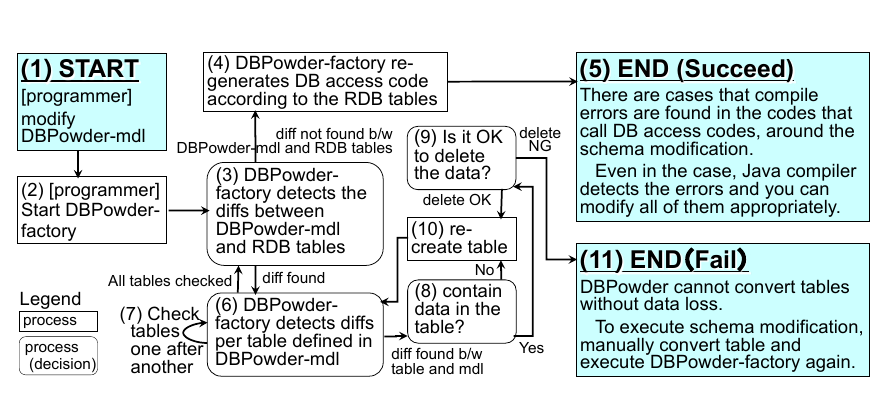
Figure 6: Flowchart of the helper for database schema